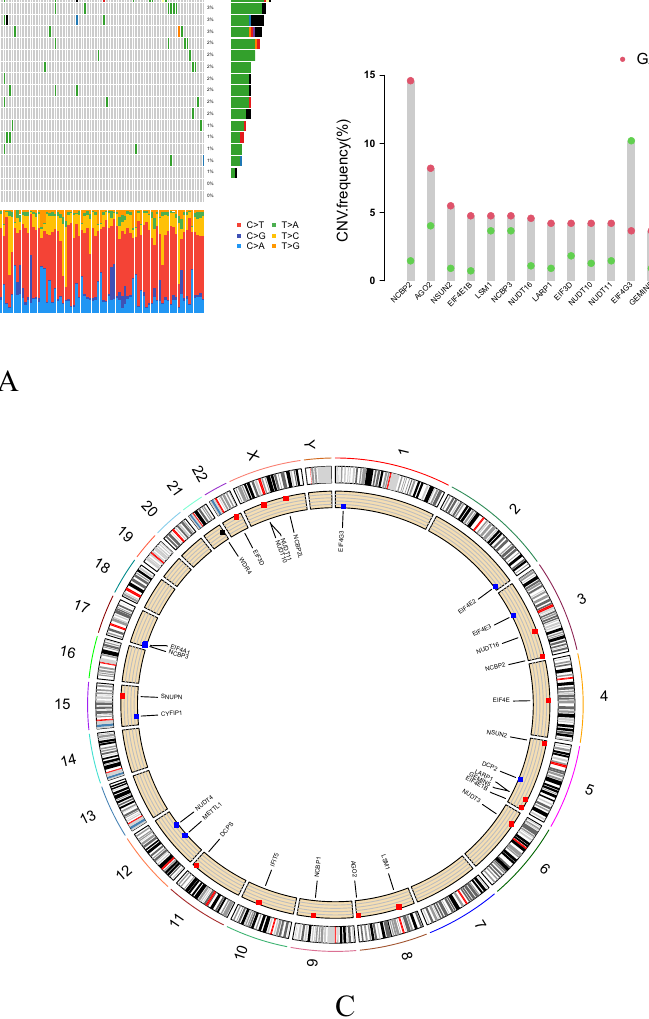
Figure 2. m7G-related gene mutations and CNV information in UCEC. ( A ) One hundred and fifty-two (28.73%) out of 529 patients show different genetic alterations. Of the missense mutation is the most common type of mutations. ( B ) 28 m7G-related gene copy number variants. ( C ) CNV change in location of intracellular m7G-related